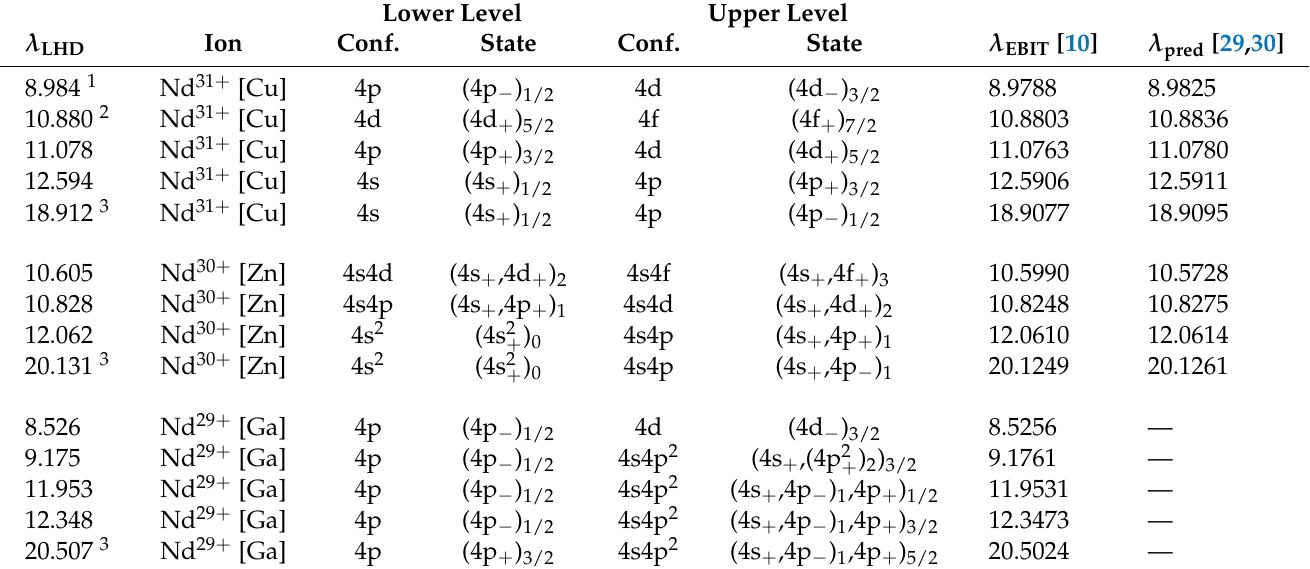
Table 1. The assignments of the lines of neodymium ions. Isoelectric sequence of each ion is shown in a square bracket. The states of the lower and upper levels are denoted in jj coupling notation. The wavelengths listed in the column λ EBIT are taken from the recent EBIT data [10], and those in the column λ pred are predicted semiempirically [29,30]. All wavelengths are in